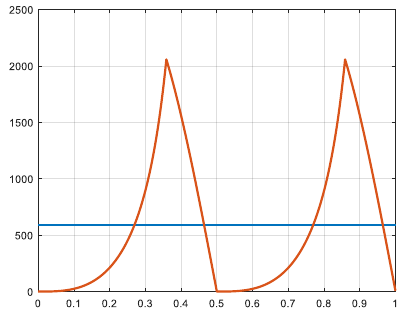
Figure 16. Power (red) and average value (blue) (W).